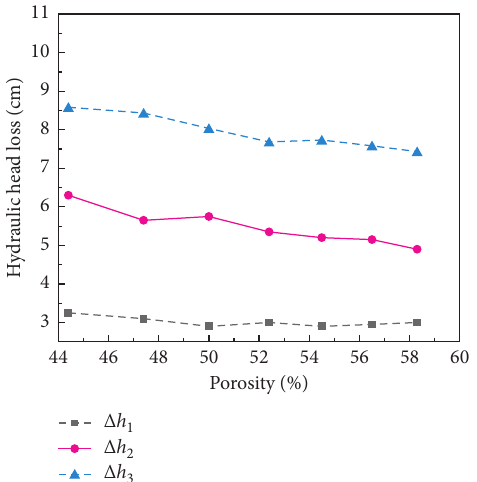
Figure 5: Relationship between hydraulic head loss and